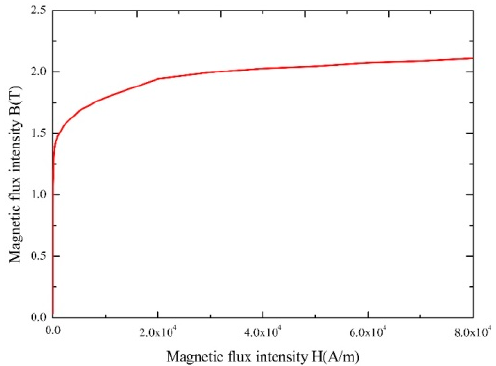
Figure 8. B-H (B stands for magnetic field intensity, while H represent magnetic induction intensity) curve of silicon steel 50W250.